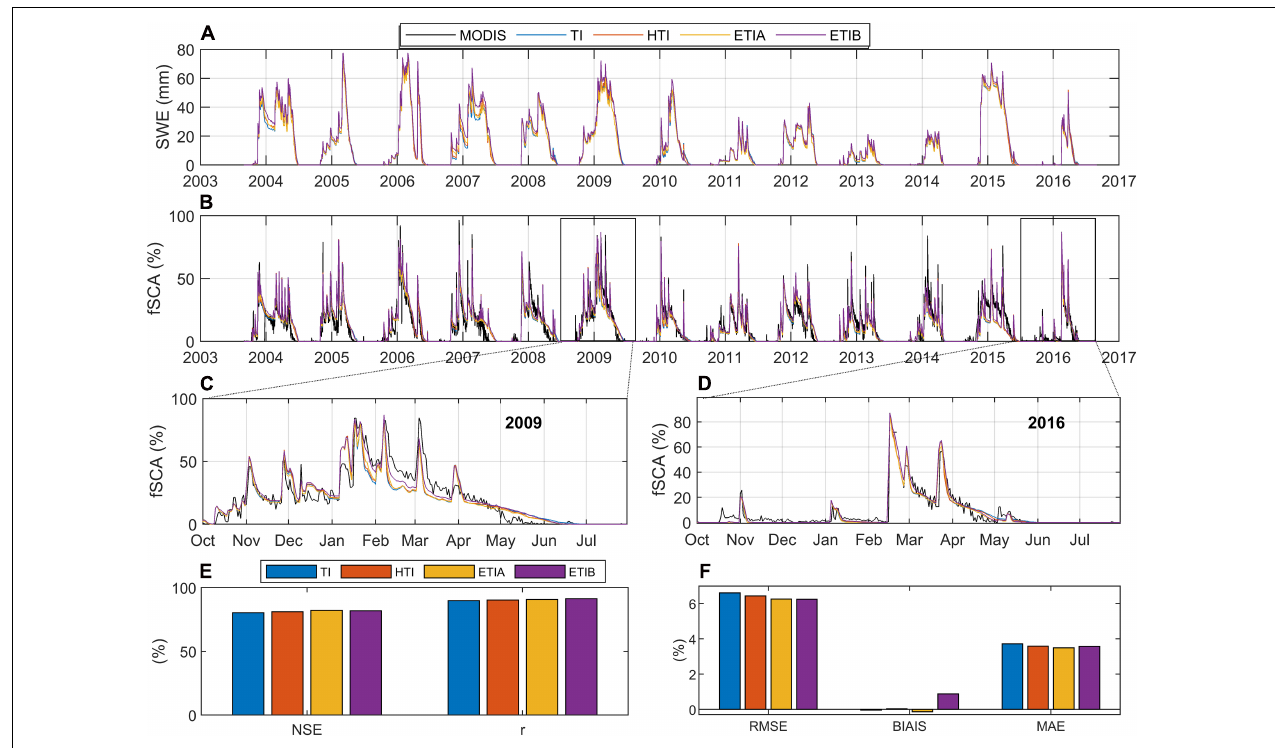
FIGURE 4 | Time series of (A) simulated mean snow water equivalent (SWE), and (B) simulated mean fractional snow cover area (fSCA) of all models vs. MODIS; (C) zoom in on 2009 year; (D) zoom in on year 2016; (E,F) errors statistics over the entire period 2003–2016 in the Rheraya catchment.